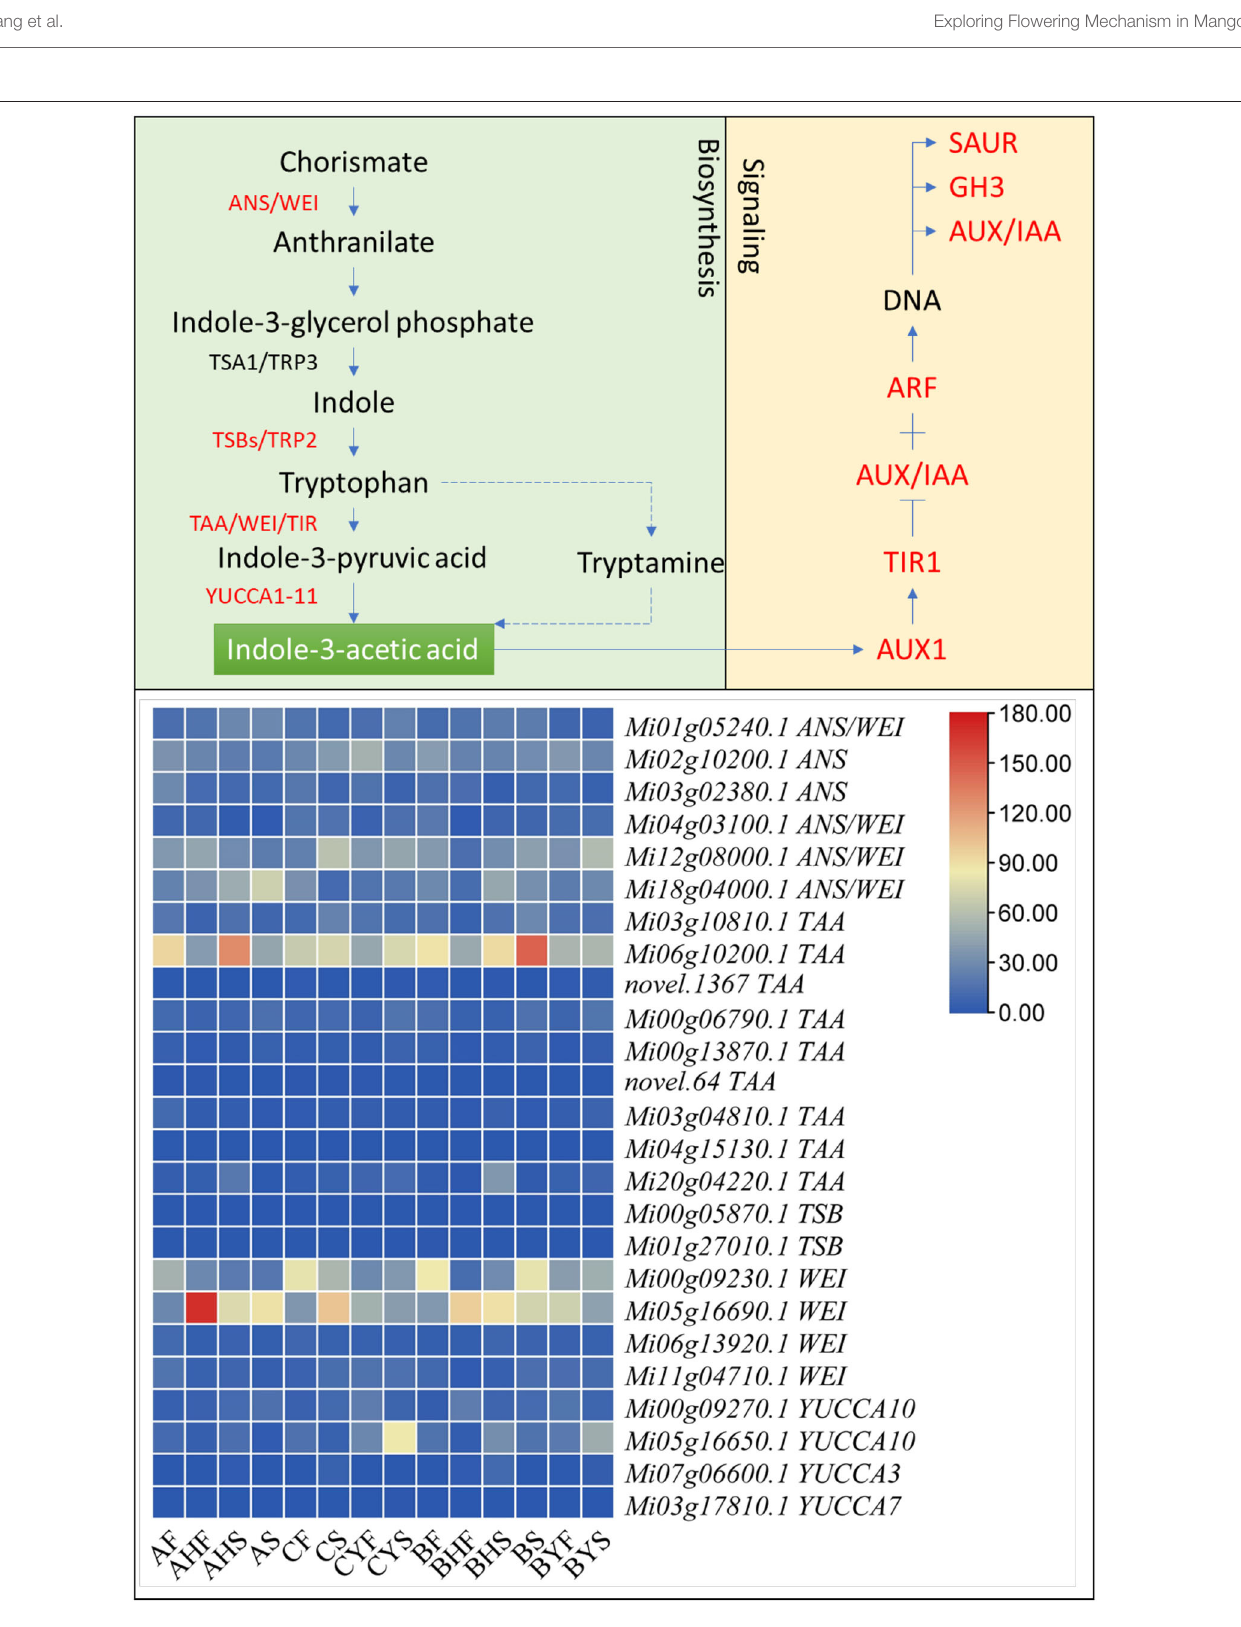
Frontiers in Plant Science |